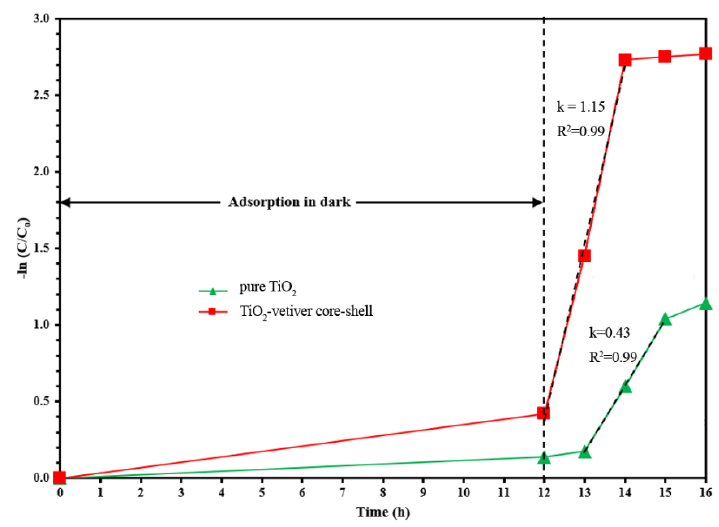
Figure 7. The kinetic of methylene blue degradation.